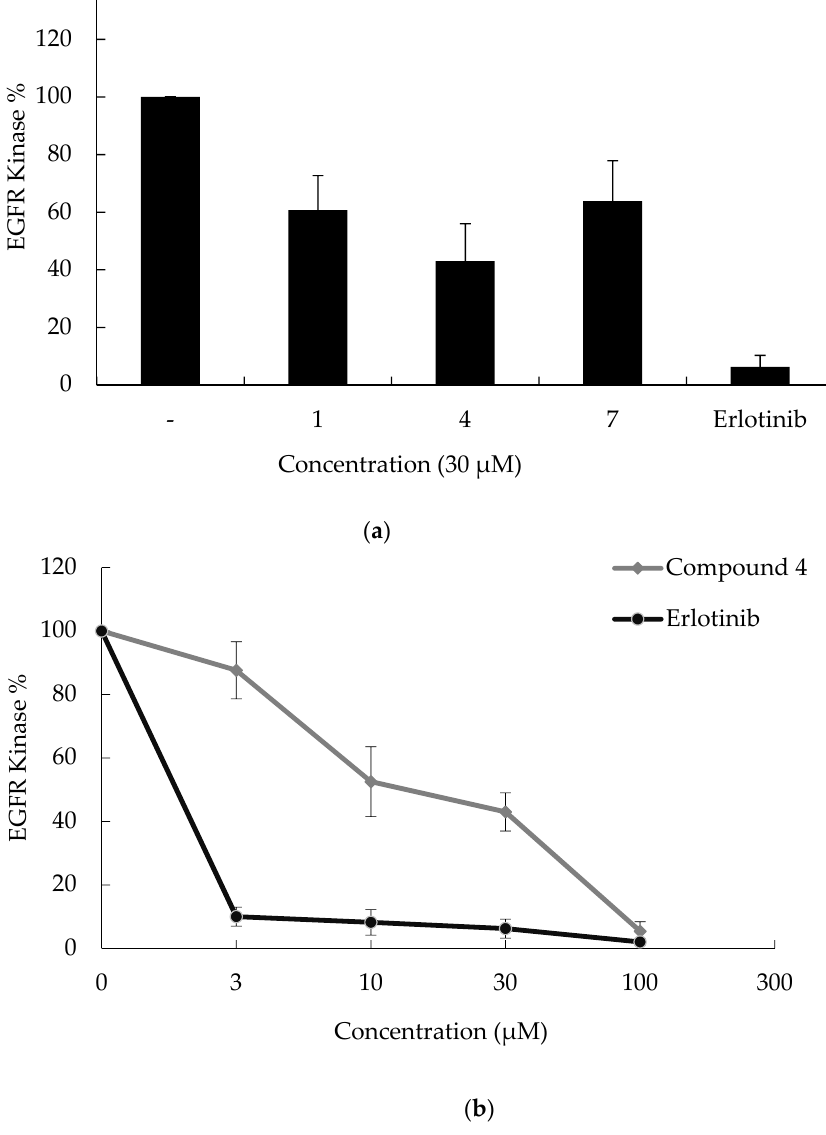
Figure 1. The inhibitory activity of the compounds on EGFR TK. ( a ) EGFR TK inhibition caused by compounds 1 , 4 , 7 , and erlotinib at 30 µM concentration. ( b ) The EGFR TK inhibition of compound 4 and erlotinib at different concentrations. All descriptive data were expressed as the Mean ± Standard Deviation (SD). All experiments were repeated three times.